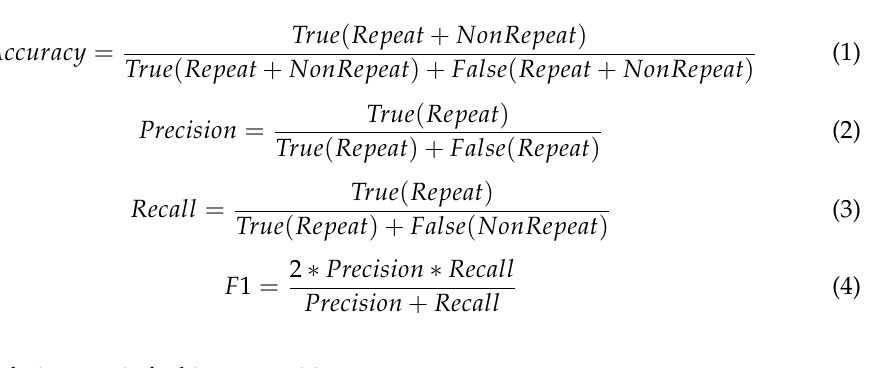
Table 6. Confusion matrix for biceps repetitions.